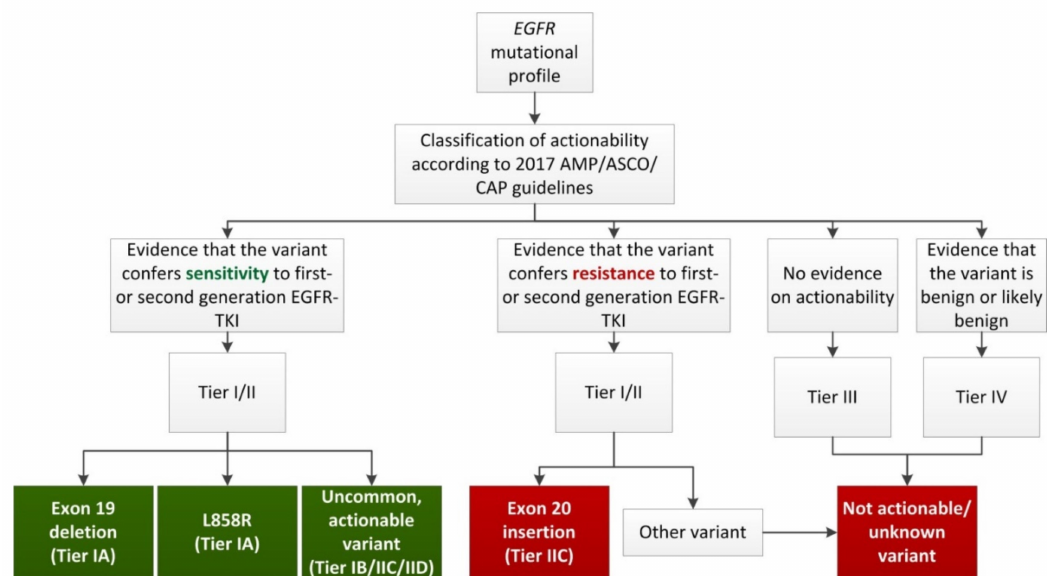
Figure 1. Flowchart used for classification of EGFR mutational profiles. Grouping of EGFR mutational profiles included in this study, based on the frequency of the mutation(s) and the corresponding AMP/ASCO/CAP level of evidence for actionability with first- or second-generation EGFR-TKI. Groups in green (Exon 19 deletion, L858R and Uncommon, actionable variants) are considered sensitive to first- or second-generation EGFR-TKI, groups in red (Exon 20 insertion and Not actionable/unknown variants) are considered resistant to first- or second-generation EGFR-TKI. In case of a double variant, actionability was assessed for the combination. However, if evidence for the combination was lacking, the patient was assigned according to the highest tier of the individual variants. Abbreviations: AMP, Association for Molecular Pathology; ASCO, American Society of Clinical Oncology; CAP, College of American Pathologists; EGFR , epidermal growth factor receptor gene; TKI, tyrosine kinase